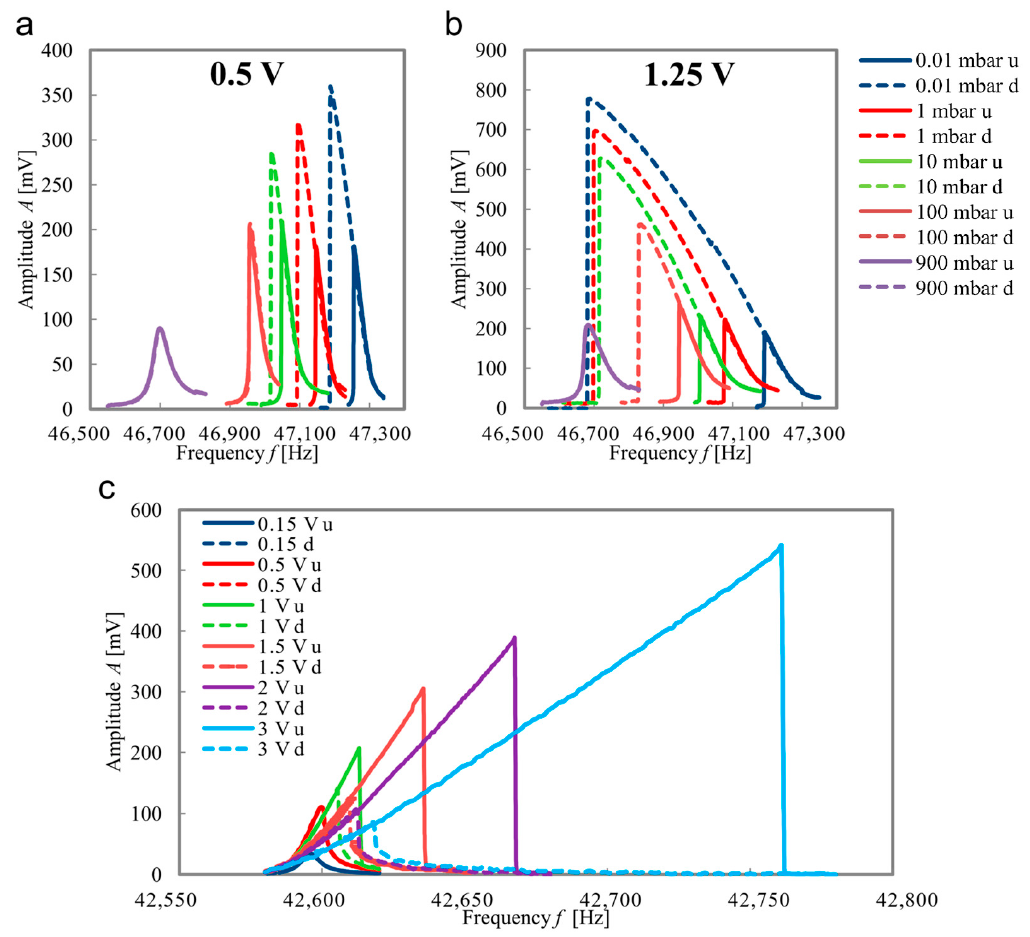
Figure 6. Amplitude frequency response in upward (u, solid) and downward (d, dotted) sweep of the 2nd roof-tile-shaped mode of sensor C_100 for different ambient pressures and for an excitation voltage of 0.5 V ( a ) and 1.25 V ( b ), respectively. Amplitude frequency response in upward (u, solid) and downward (d, dotted) sweep of the 2nd roof-tile-shaped mode of sensor C_33 for different excitation voltages at a fixed ambient pressure of 1 mbar ( c